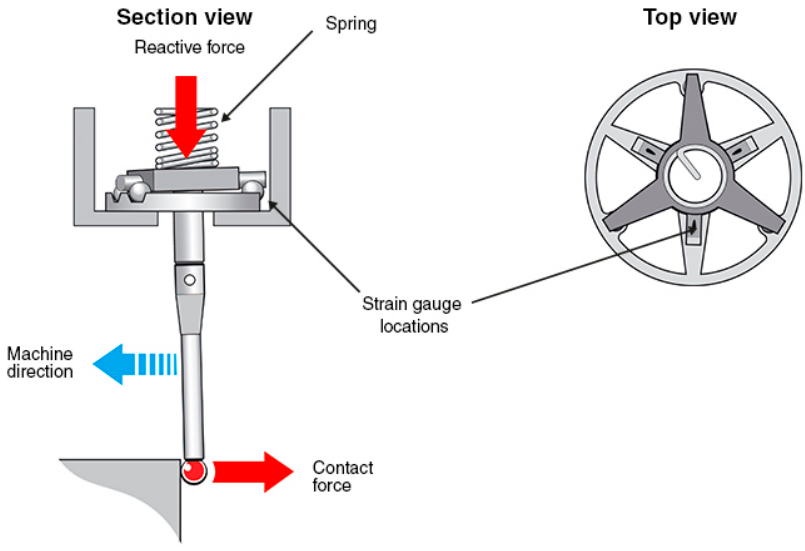
Figure 14. Kinematic resistive probe principle [141]. (Copyright Renishaw plc. All rights reserved. Image (s) reproduced with the permission of Renishaw.)